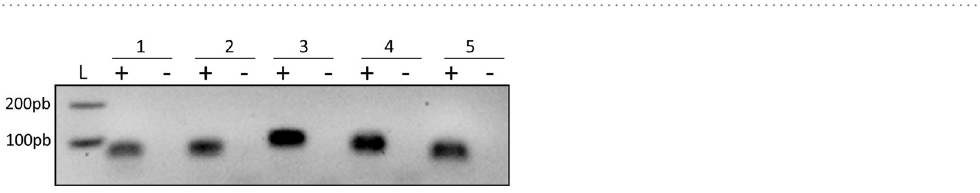
Figure 2. Antisense transcription detected on the opposite strand of some newly identified RNAs through MiSeq RNA sequencing. RT-PCR was performed on RNA extracted from cells collected at an OD 600nm of 6. Lanes 1 to 5 show IGR_1080208, IGR_1141547, IGR_1141775IGR, IGR_2019414 and 2019159, from left to right after cDNA synthesis ( + ) or after DNase treatment ( − ). The gel presented here was cropped for clarity